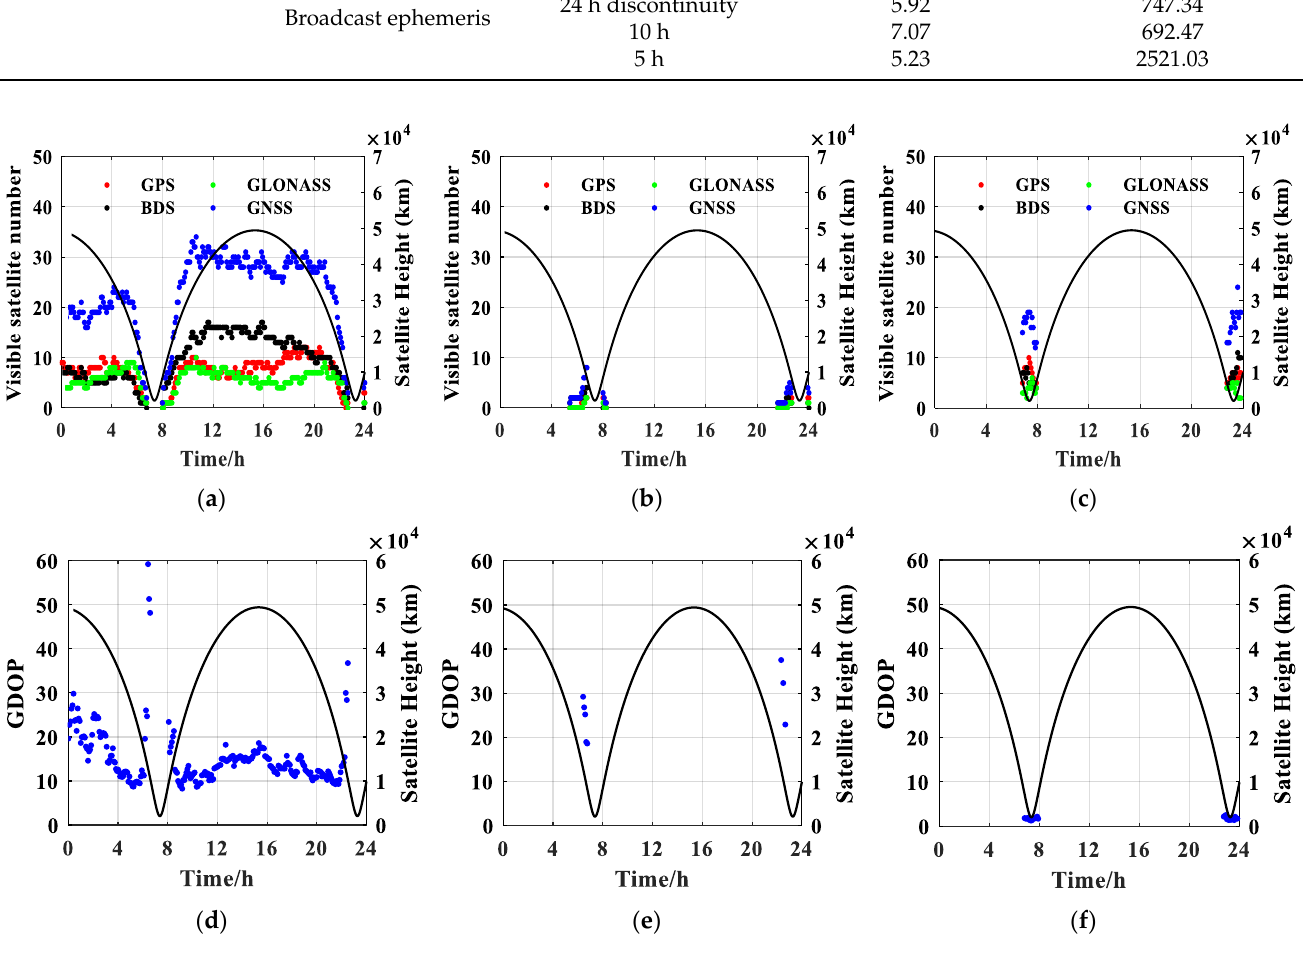
Figure 6. Visible GNSS number and GDOPs of antennas 1, 2, and 3. ( a ) Visible GNSS number of antenna 1. ( b ) Visible GNSS number of antenna 2. ( c ) Visible GNSS number of antenna 3. ( d ) GDOP of antenna 1. ( e ) GDOP of antenna 2. ( f ) GDOP of antenna 3.